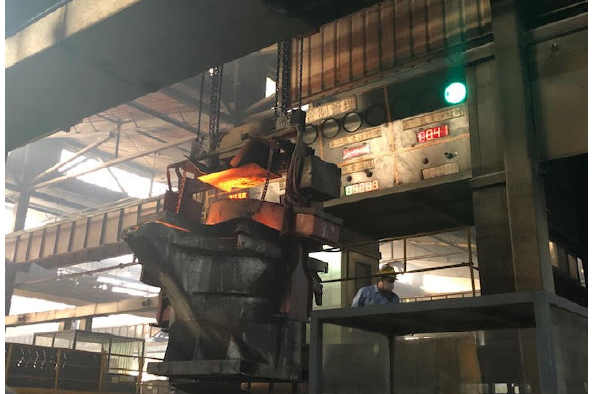
Figure 4. The hanging pot moves to the moldings.